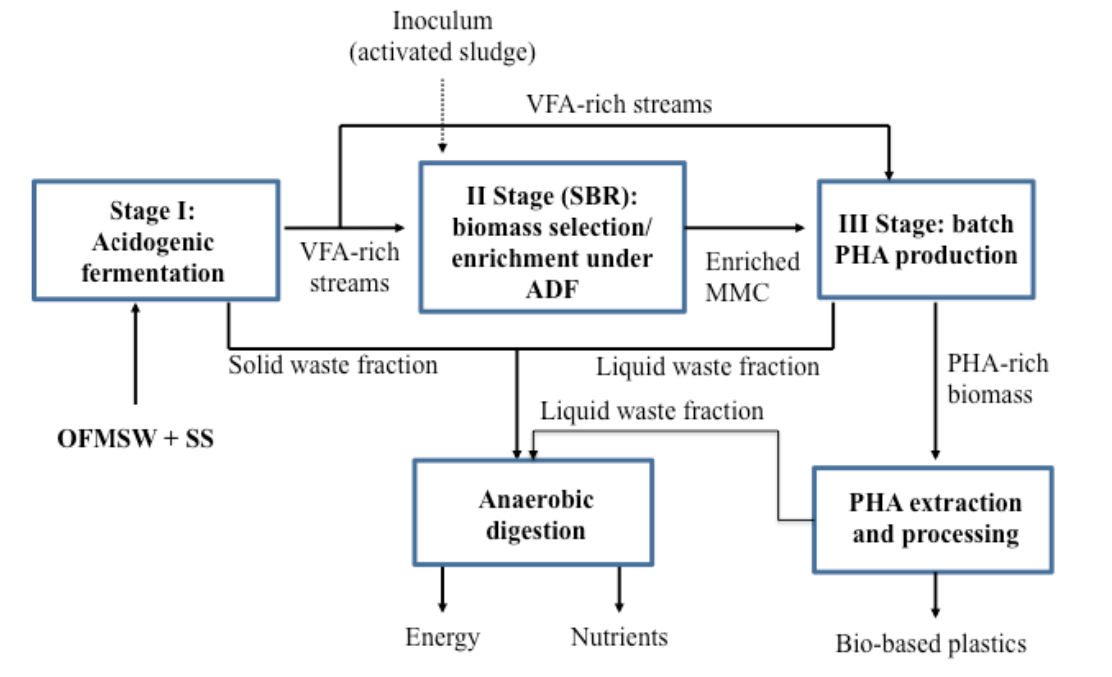
Figure 2. PHA production process.